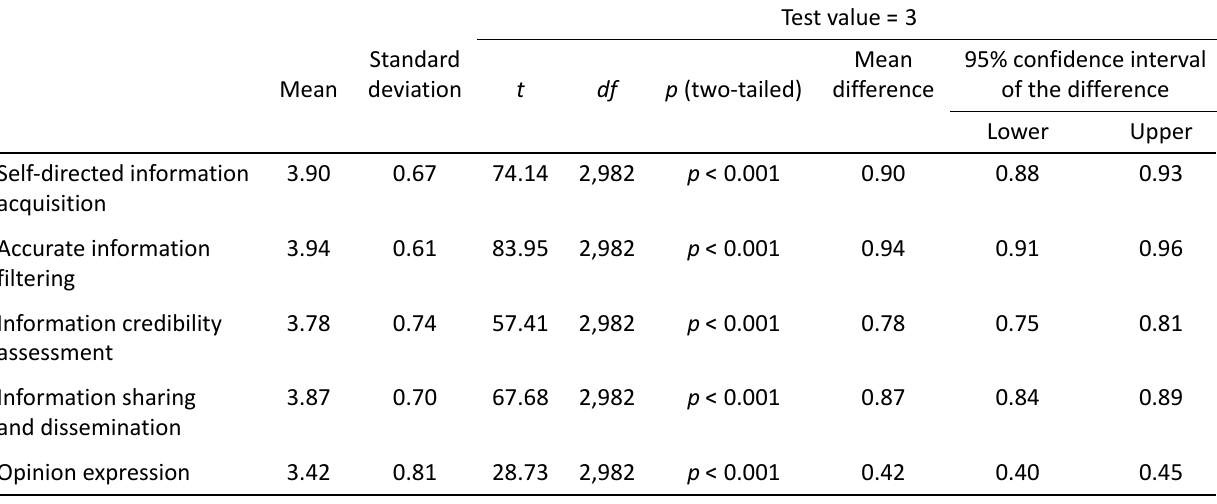
Table 5. Results of one‐sample